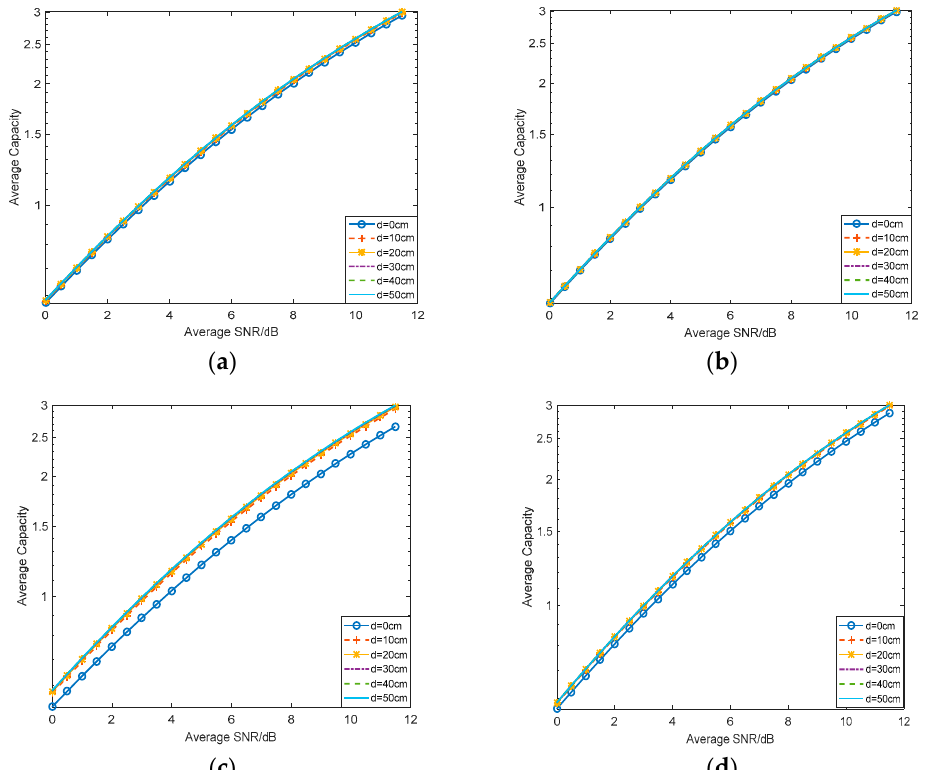
Figure 6. Performance of average capacity with different diameters, turbulence conditions and zenith angles are: ( a ) A = 1.7 × 10 − 14 , w = 10, ζ = π /3; ( b ) A = 1.7 × 10 − 14 , w = 10, ζ = π /6; ( c ) A = 3.0 × 10 − 13 , w = 21, ζ = π /3; ( d ) A = 3.0 × 10 − 13 , w = 21, ζ = π /6.